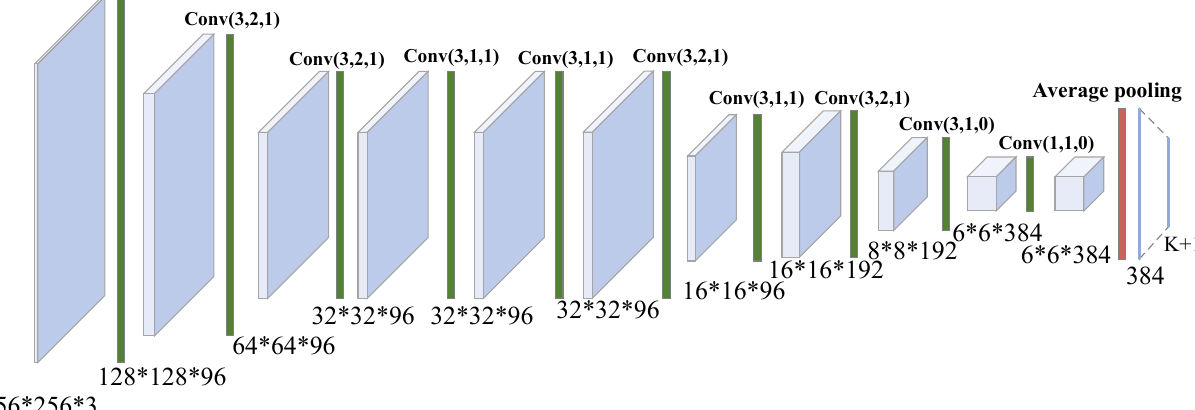
Figure 5. The architecture of the